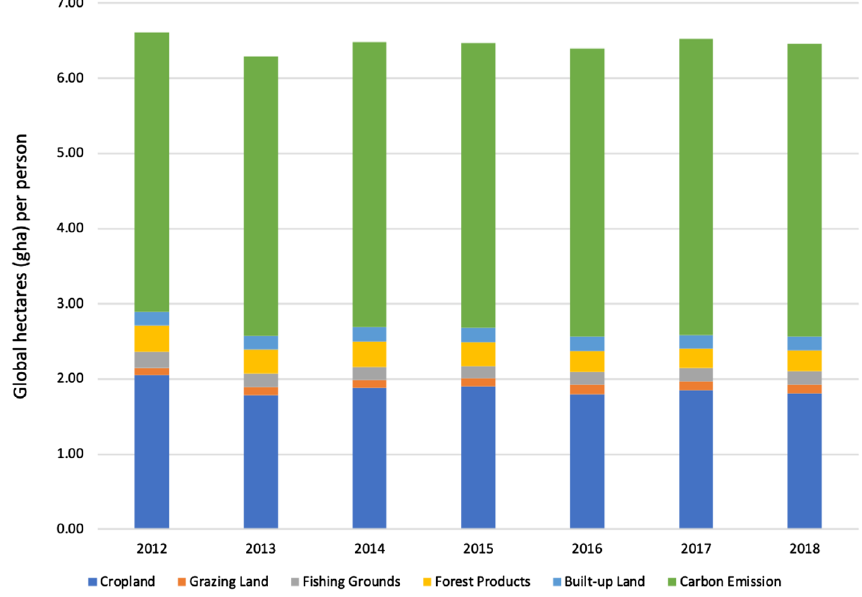
Figure 2. Changes in the footprints of six types of bioproductive land from 2012 to 2018.